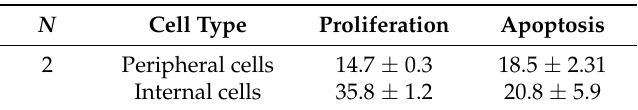
Table 5. Proliferation indexes (Ki67) and percentages of apoptotic cells (TUNEL) in corpora lutea of Typhlonectes compressicauda . N : number of